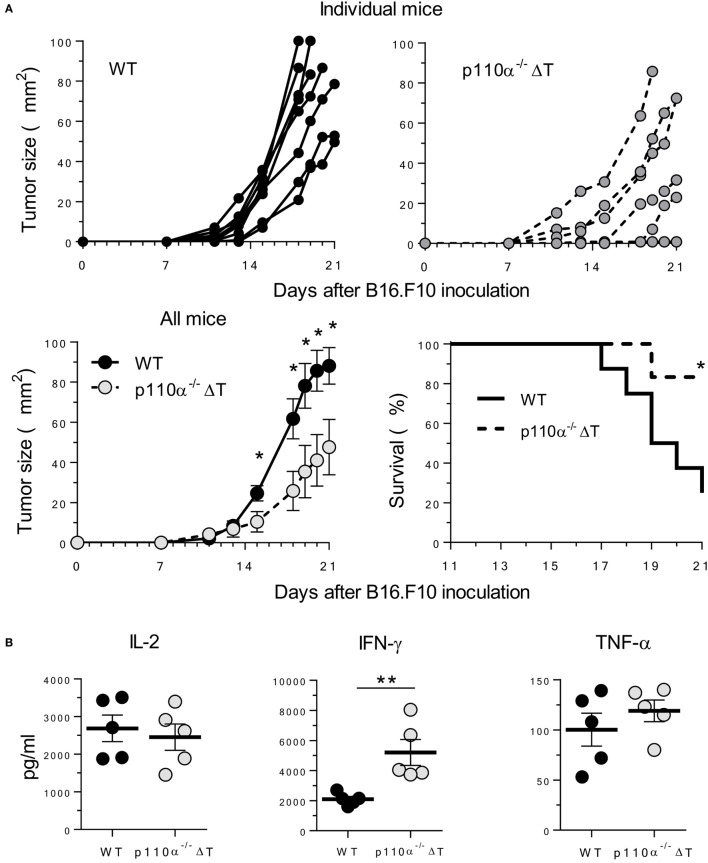
PI3-kinase p110α-deficiency in T cells inhibits the growth of B16.F10 melanoma cells. (A) B16.F10 melanoma cells were injected s.c. in WT or p110α-T cell deficient (p110α−/−ΔT) mice. Then, tumor growth and survival of mice were determined, as indicated. Data from two experiments are depicted as tumor size in individual mice (top panels) or as mean ± SE from n = 8 (WT) or n = 6 (p110α−/−ΔT) mice. Significant differences (*p < 0.05) are indicated, as determined by the Student’s t-test (lower left) or the long-rank Mantel–Cox test (lower right). (B) Spleen cells from melanoma-bearing mice were activated “in vitro” with melanoma proteins for 96 h. Then, cytokines in the supernatant (IL-2, IFN-γ, TNF-α) were determined. Data from two experiments. Individual values from n = 5 (WT) or n = 5 (p110α−/−ΔT) mice and means ± SE, are depicted. Significant differences are indicated (**p < 0.01), as determined by the Student’s t-test. (C) Expression of cell surface (CD4, CD8, PD-1) or intracellular markers (Foxp3) as determined by flow cytometry of spleen cells from WT (n = 6) or p110α−/−ΔT (n = 6) melanoma-bearing mice. Data expressed as percentage of cells or as mean fluorescence of Foxp3 in CD4+Foxp3+ cells (lower right panel). Individual values and mean ± SE are shown. Significant differences (* p < 0.01), as determined by the Student’s t-test, are indicated.